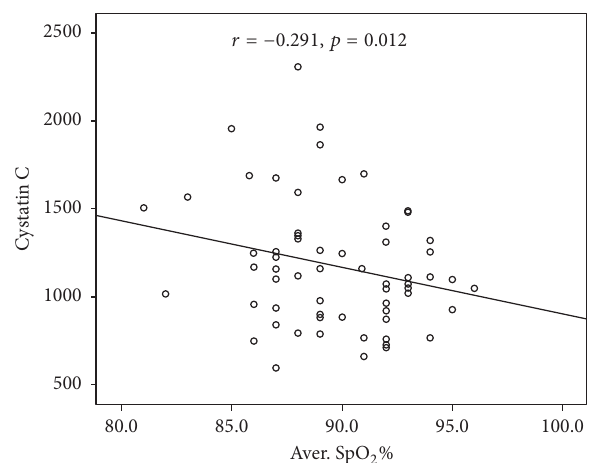
Figure 1: Correlation between Cystatin C levels and respiratory disturbance index (RDI) in OSAS patients.